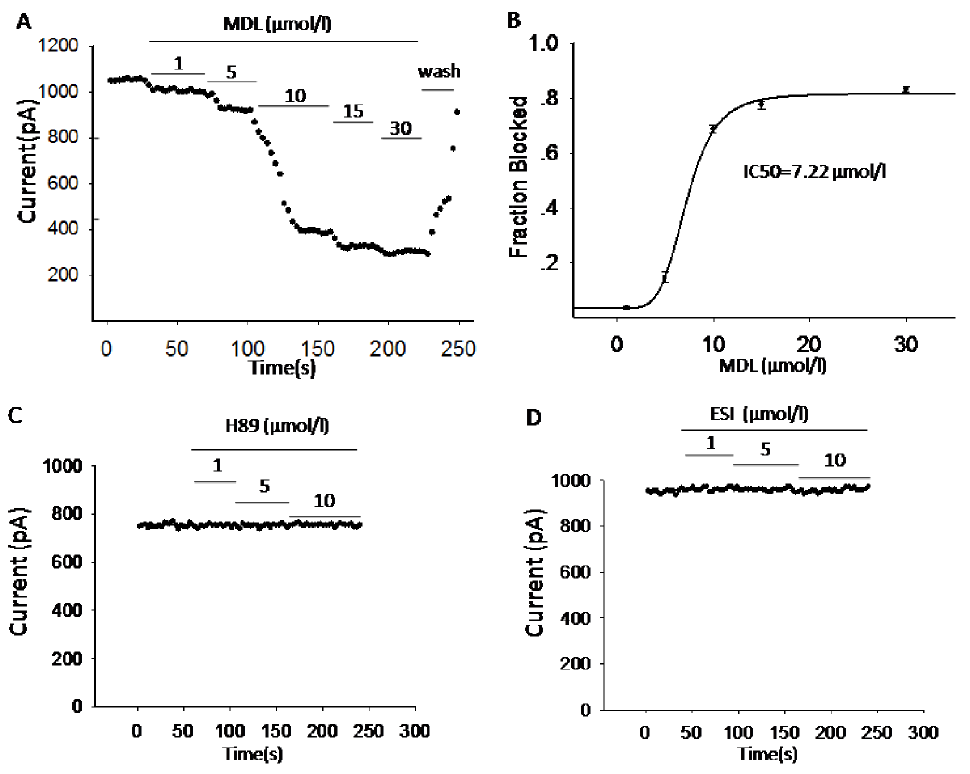
Figure 4. MDL-12,330A inhibits K V currents in a dose-dependent manner in rat beta cells. A. representative time-response curve of K V currents in response to 400 ms voltage steps to + 70 mV in the absence and presence of 1, 5, 10, 15 and 30 m M MDL-12,330A (MDL) in the same cell. The holding potential was 2 70 mV and voltage steps were applied every 3 s in perforated whole-cell configuration. The addition of MDL-12,330A is indicated by the bar with the specific concentrations. B. plot of the fraction of control current blocked (Fraction Blocked) versus MDL-12,330A concentration for all cells tested (n=5). The continuous line is a fit of the four-parameter logistic equation to the data. Parameters of the fit are: IC 50 =7.22 m M. C and D. representative time-response scatterplot of K V currents in the absence and presence of H89 (n=7) and ESI-09 (ESI, n=7).